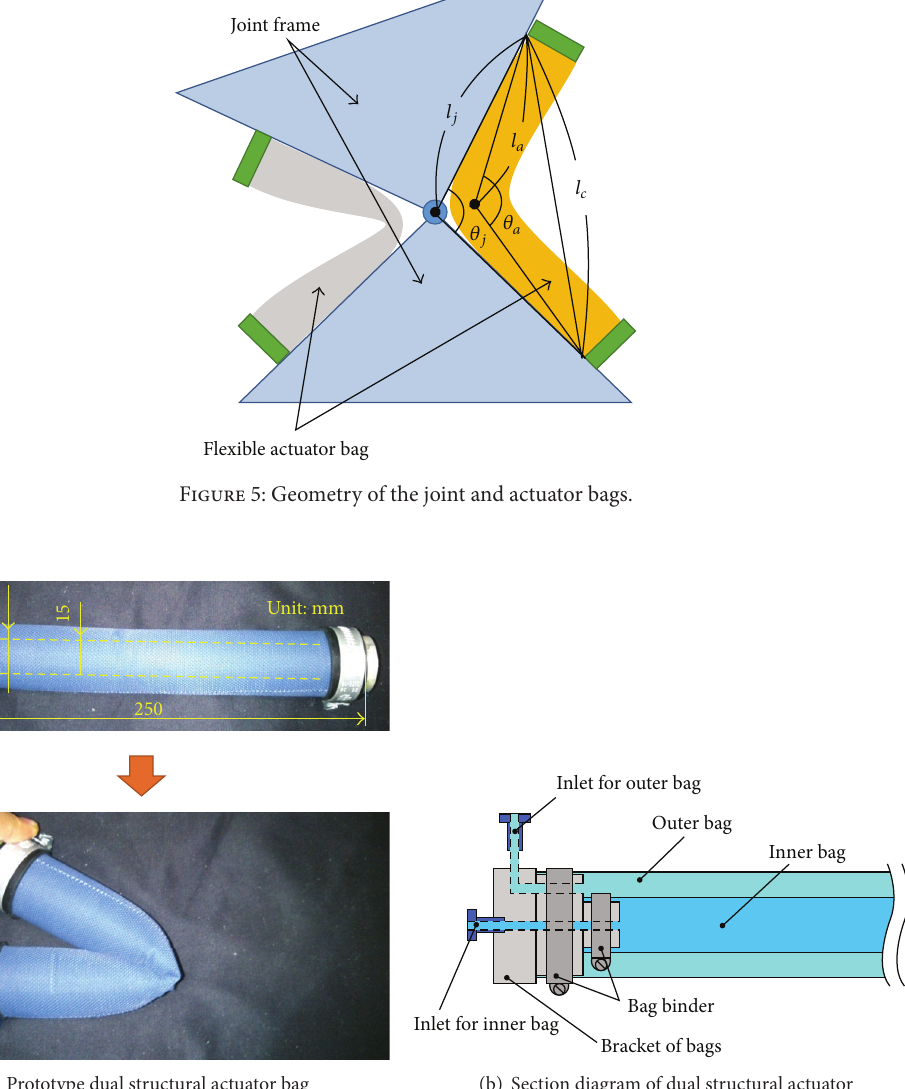
Figure 6: Dual structural